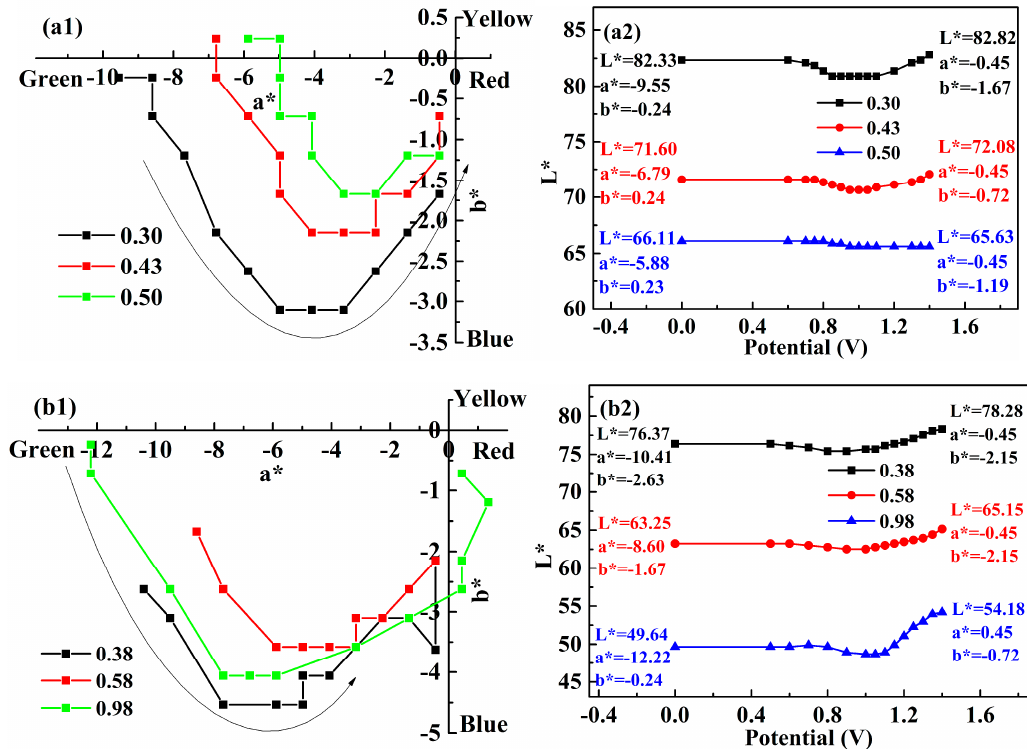
Figure 9. CIE L * a * b * color coordinates for the copolymers PITID-1 ( a ) and PITID-2 ( b ) films during p-doping processing from neutral state to oxidized states with three measurable thicknesses.